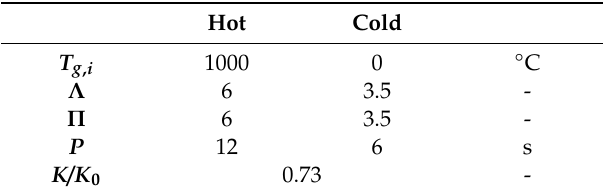
Table 2. Input data for calculation.